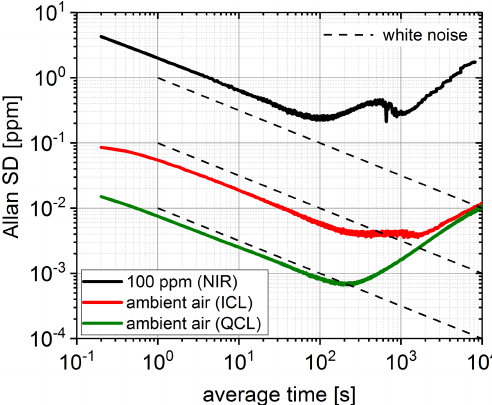
Figure 8. Allan standard deviation σ A versus integration time τ for the PAS measurements using the calibrations of Fig. 6a. Dashed √ τ dependence for white noise (black) lines indicating a typical 1 / √ τ for a typical drift behaviour (red) are shown as guides for and the